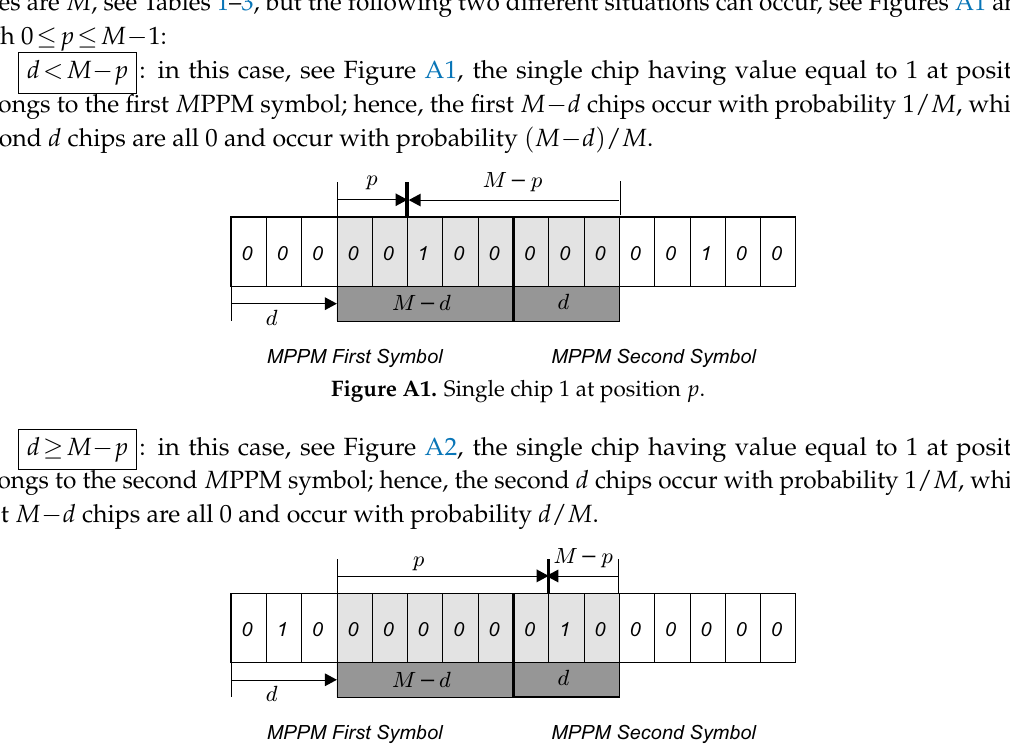
Figure A2. Single chip 1 at position p